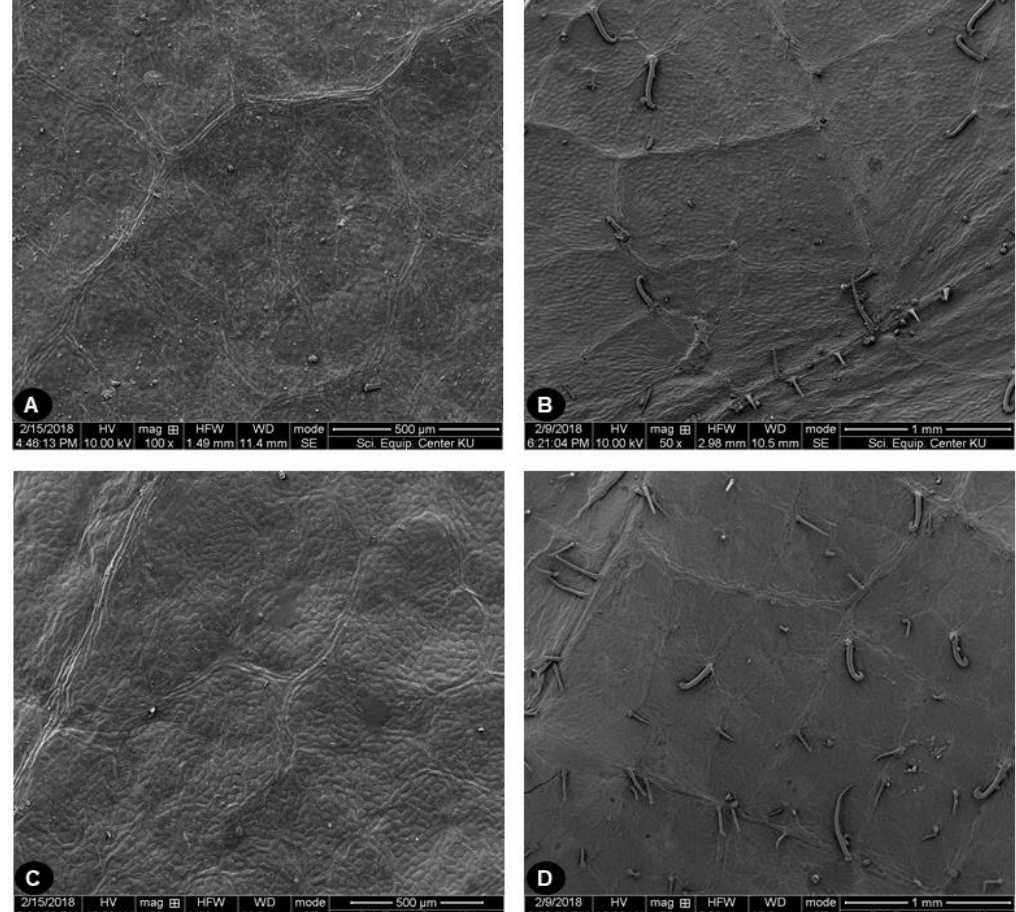
Figure 3. Upper surface of leaf micromorphology study by SEM of A. lacucha and A. thailandicus . ( A ) Upper surface of A. lacucha (voucher PBM05214), glabrous ( B ) Upper surface of A. lacucha (voucher PBM05218), with straight and uncinate smooth hair ( C ) Upper surface of A. thailandicus , glabrous (voucher PBM05203) ( D ) Upper surface of A. thailandicus (voucher PBM05229), with straight and uncinate smooth